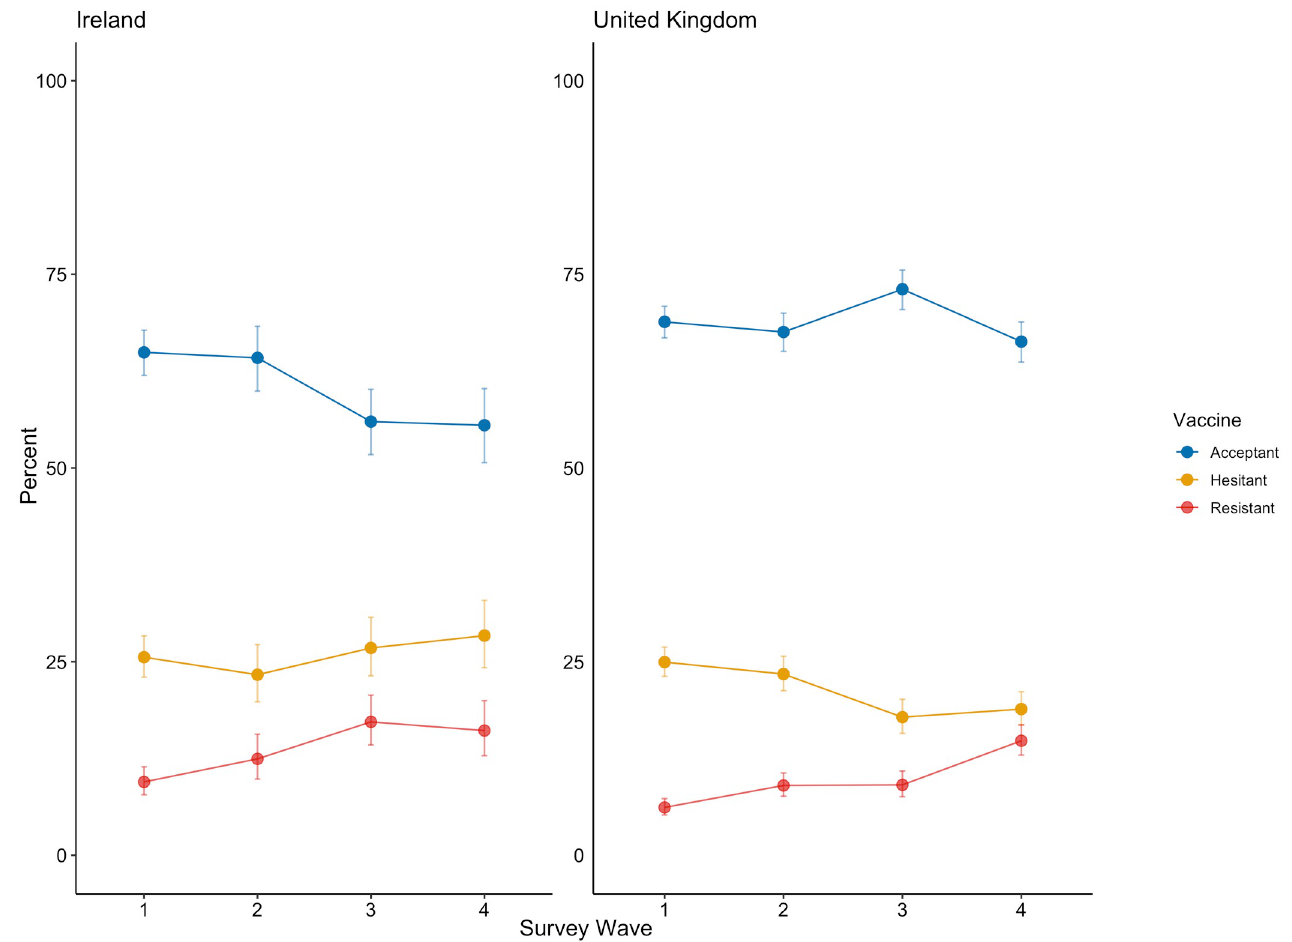
Fig 1. COVID-19 vaccine acceptance, hesitance, and resistance in the Irish and UK samples. Data are presented as the proportion of the Irish (n = 1030) and United Kingdom (n = 2000) samples indicating COVID-19 acceptance (blue line), hesitance (orange line), and resistance (red line) across four waves of